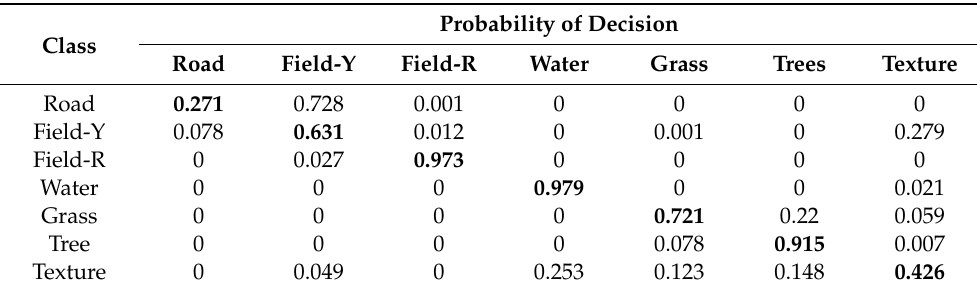
Table 8. Confusion matrix for compressed image classified by NN trained for original image and applied for the compressed image (PSNR-HVS-M = 36 dB).